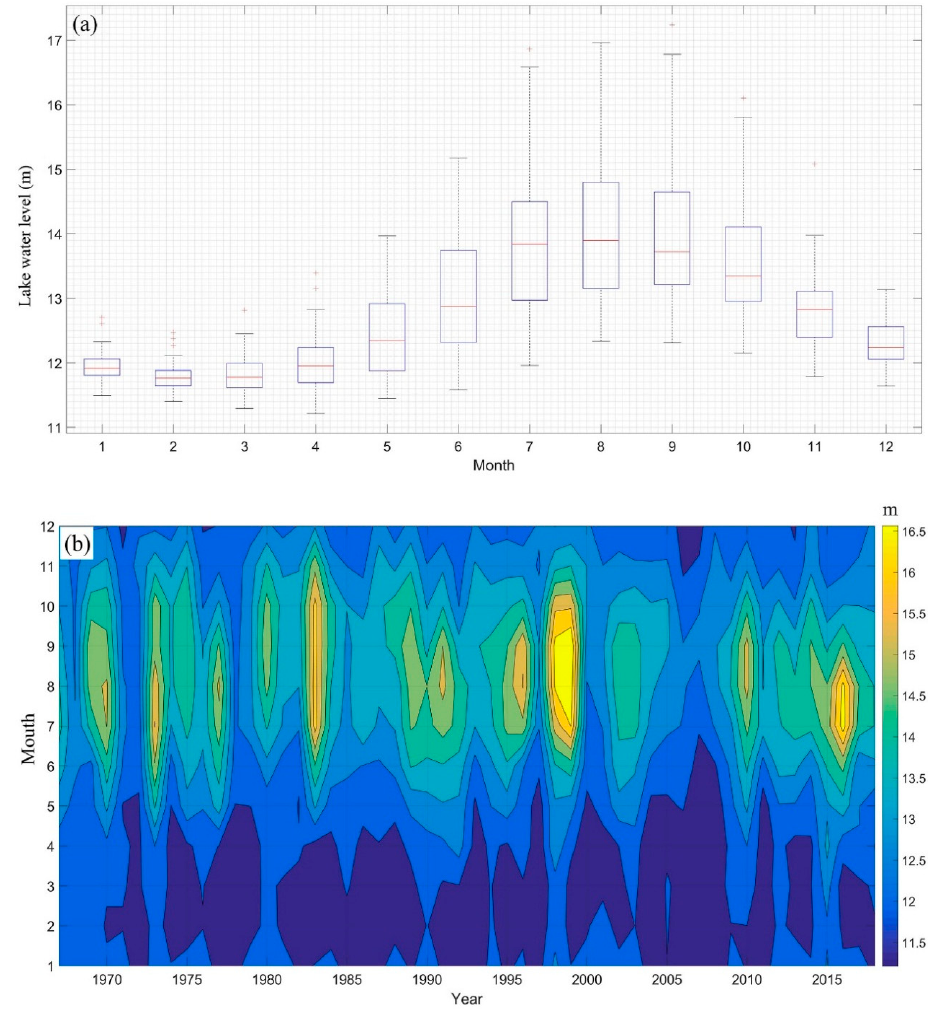
Figure 3. ( a ) Box-whisker plots of monthly water level from 1967 to 2018 in Huayang Lakes; and ( b ) Seasonal water level variation from 1967 to 2018 in Huayang Lakes.